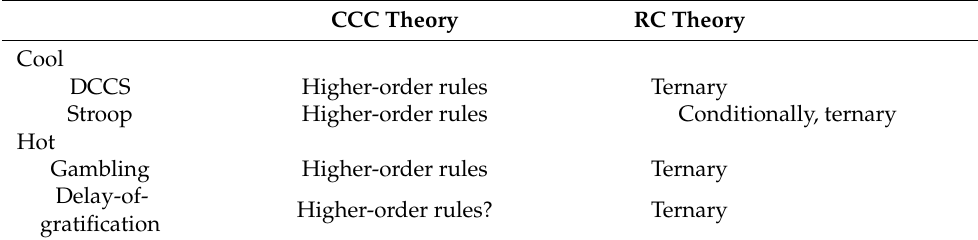
Table 2. Cognitive complexity of cool and hot EF